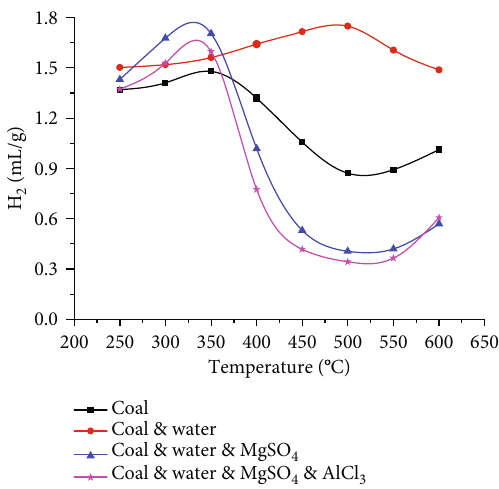
Figure 6: Variation characteristics of H